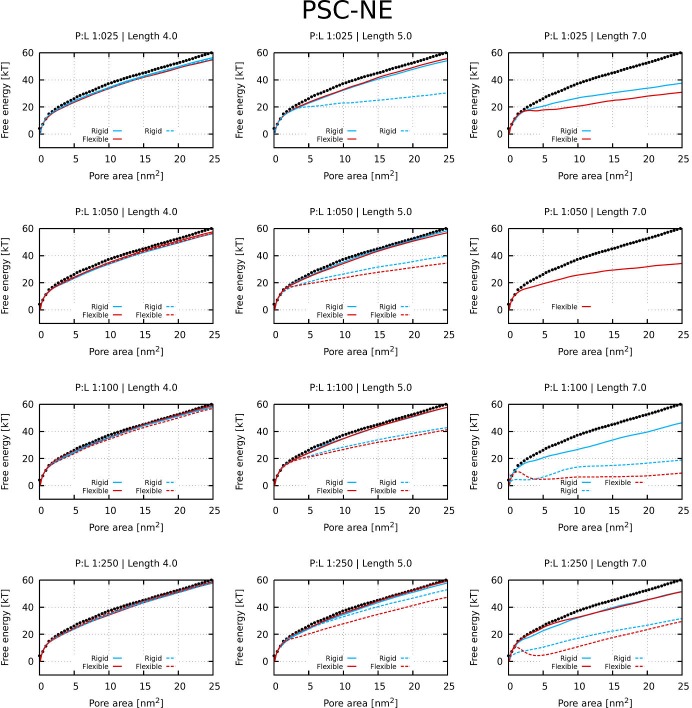
Free energy profiles of pore formation by PSC-NE peptides.Standard and more hydrophobic PSC-NE peptides are shown in full and dashed lines, respectively. The dotted line corresponds to the free energy profile of our reference system, a pure membrane without any peptides.